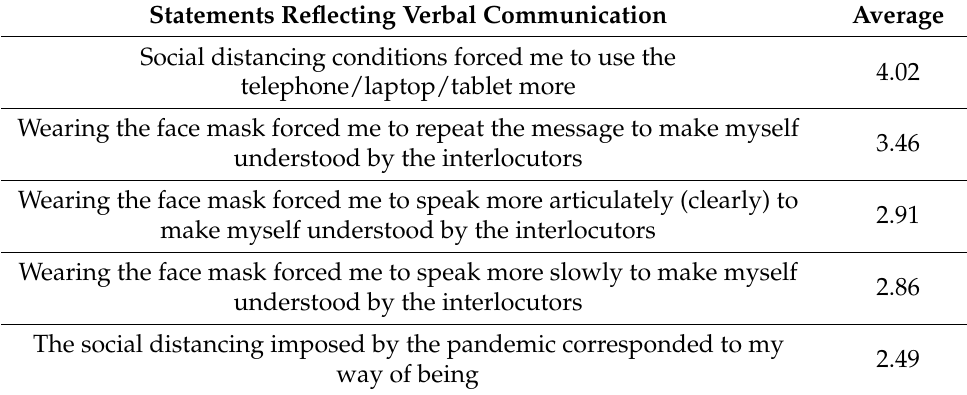
Table 1. Statements reflecting verbal communication on a scale from 1 to